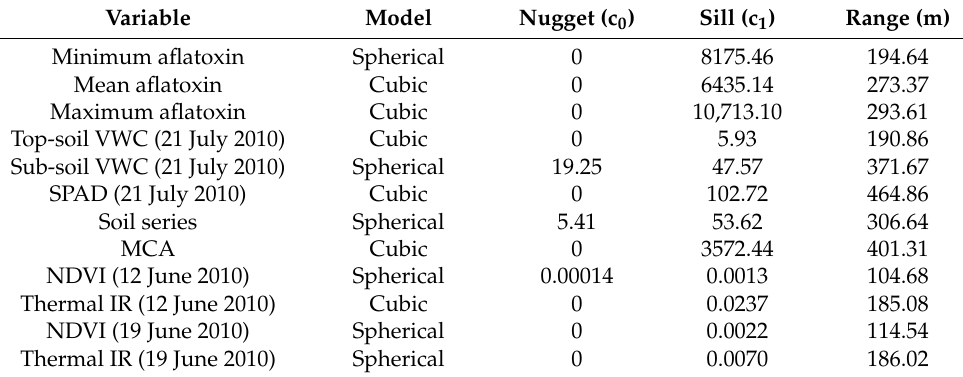
Table 2. Variogram parameters used for kriging field observation data and parameters of variograms for selected imagery